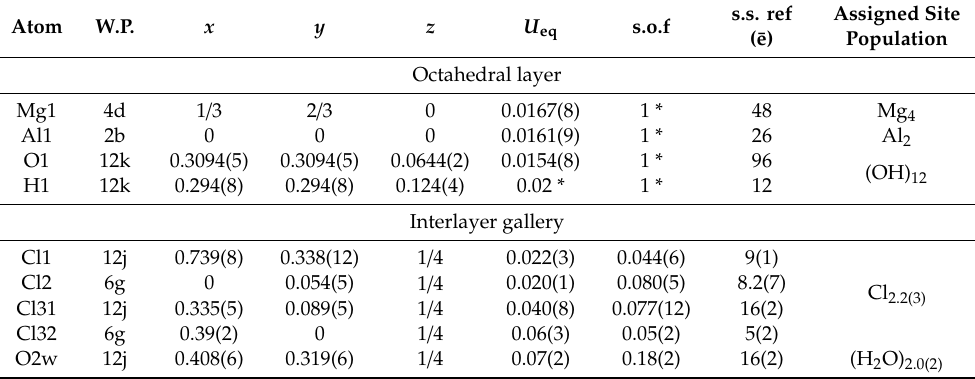
Table 5. Atom coordinates, equivalent isotropic displacement parameters (Å 2 ), site occupancies, and assigned site populations for chlormagaluminite.